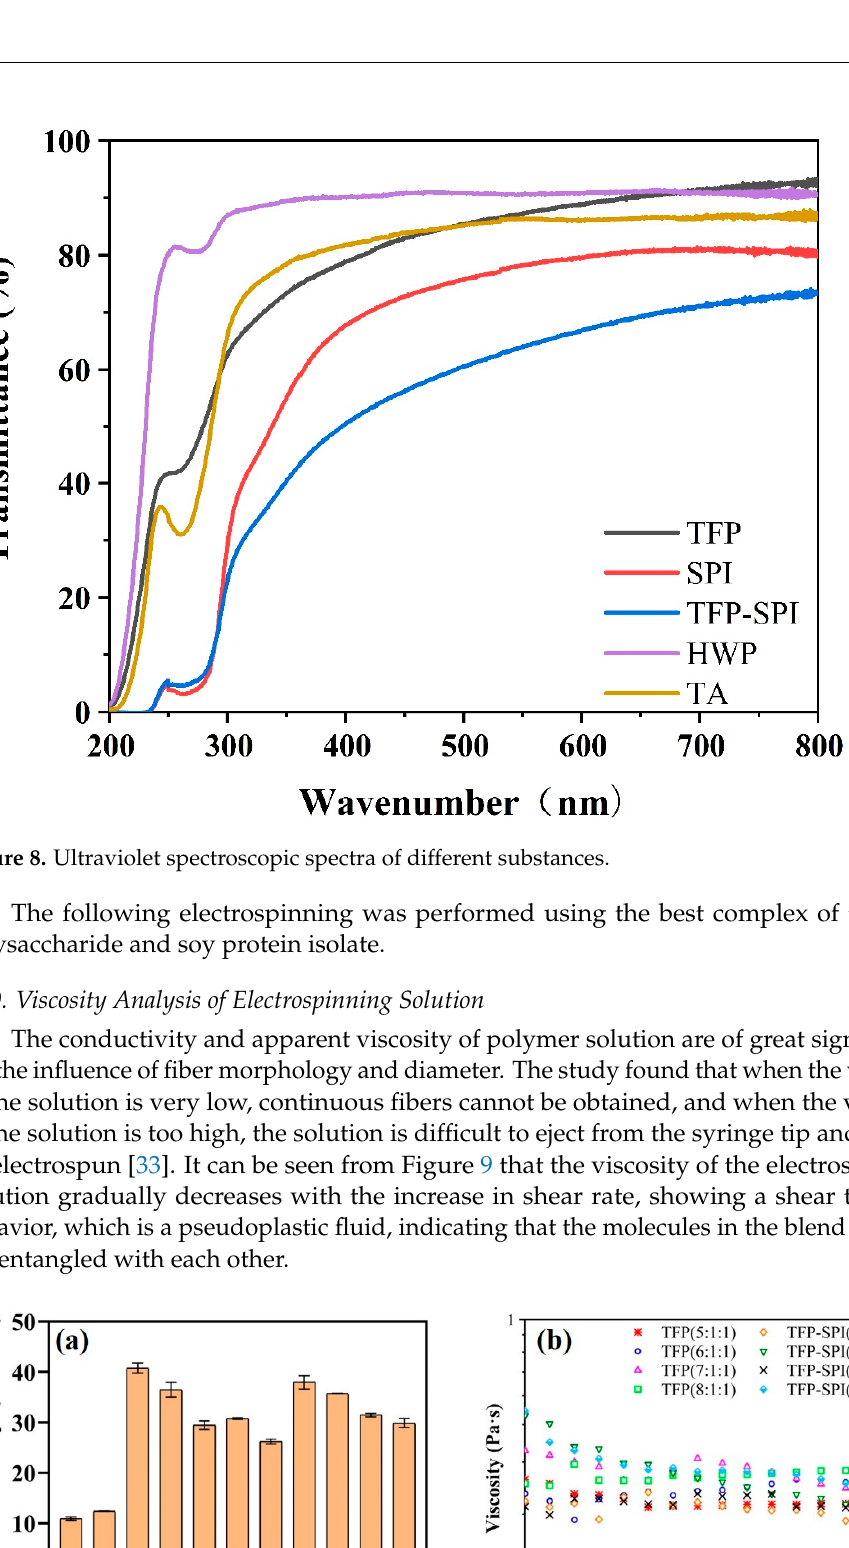
conductivity helps to form nano fi bers with good morphology and uniform diameter. 3.12. Microstructure Analysis of Electrospun Nano fi ber Membrane Studies have shown that for the spinning solution, too high viscosity and too low conductivity will hinder the stretching of the fi ber during the je tt ing process. The resulting fi ber has a large and uneven diameter, and even causes the droplets to accumulate at the je tt ing pinhole of the syringe and cannot be electrospun [11]. Figure 10 is the scanning electron microscope images of electrospun nano fi bers with di ff erent proportions of tremella polysaccharide and di ff erent proportions of composite. It can be seen from the fi gure that as the proportion of the polymer increases, the fi ber becomes more and more uniform, and the beads decrease. When the ratio of PVA/TFP-SPI/PL reaches 8:1:1, the fi ber diameter is uniform and no beads are produced. Figure 10. SEM images of nano fi bers under di ff erent condition. ( a ). PVA/TFP/PL(5:1:1); ( b ). PVA/TFP/PL(6:1:1); ( c ). PVA/TFP/PL(7:1:1); ( d ). PVA/TFP/PL(8:1:1); ( e ). PVA/TFP-SPI/PL(5:1:1); ( f ). PVA/TFP-SPI/PL(6:1:1); ( g ). PVA/TFP-SPI/PL(7:1:1); ( h ). PVA/TFP-SPI/PL(8:1:1).